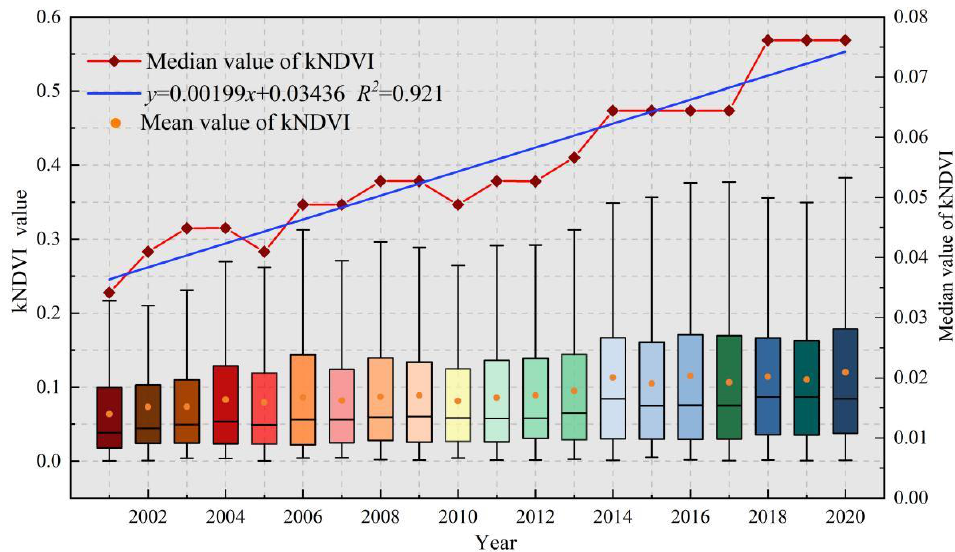
Figure 4. Temporal variation of median kNDVI in the YRB from 2001 to 2020. The left axis represents the kNDVI value of the box plot, and the right axis represents the median kNDVI value.